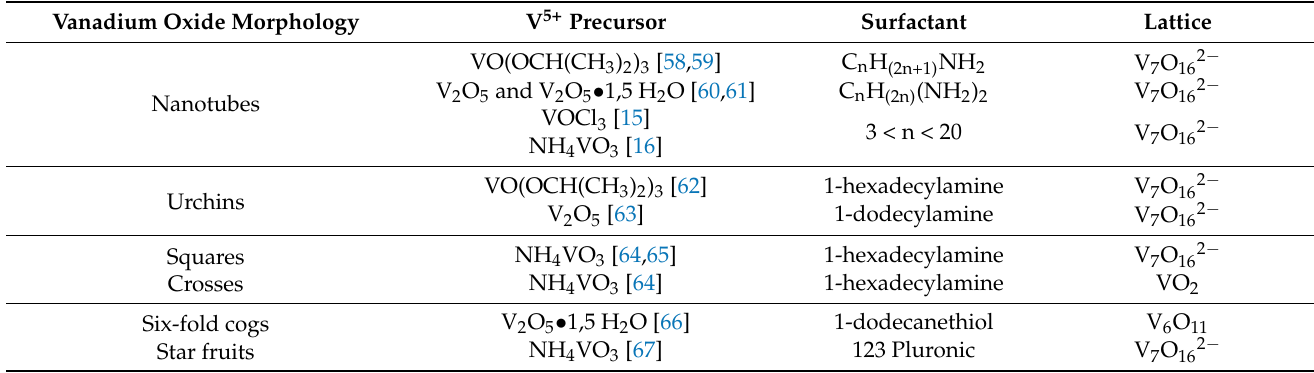
Table 1. Synthetic procedures to obtained different vanadium oxide nano and microstructures under hydrothermal treatment.